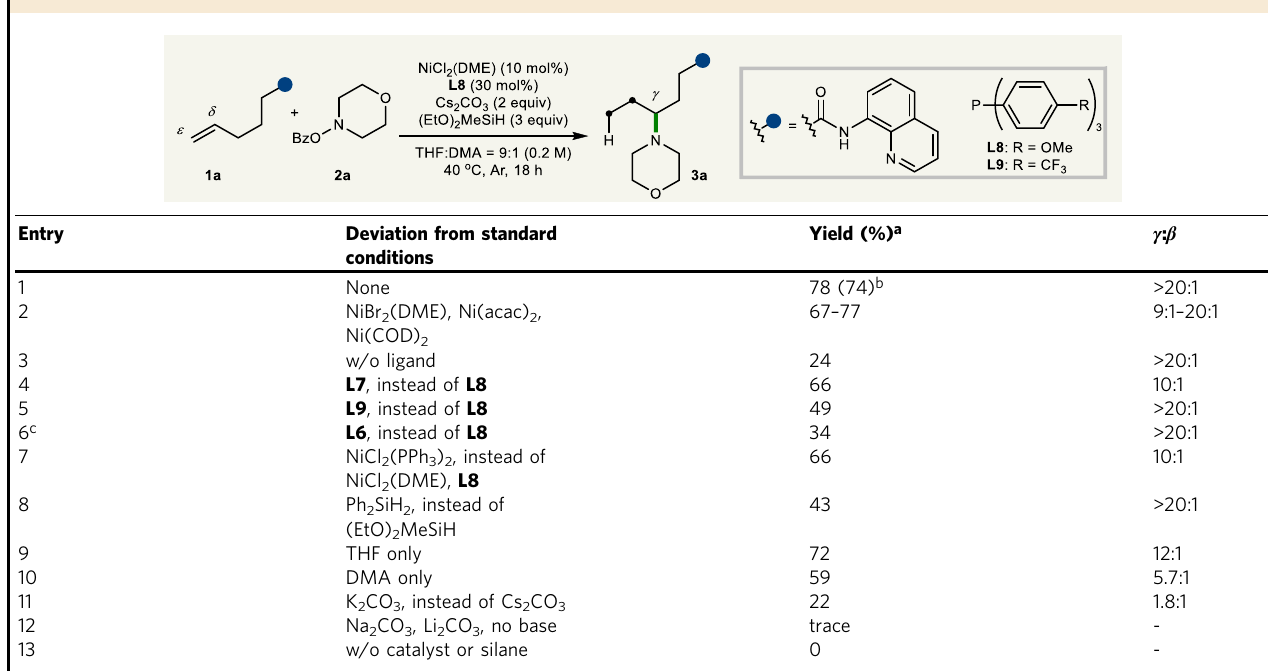
Table 1 Optimization of the reaction